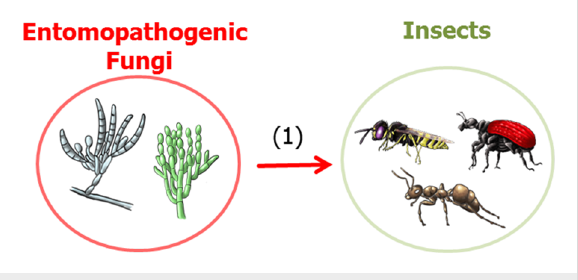
Figure 10: Predatory interactions, (1) entomopathogenic fungi use insect as prey.